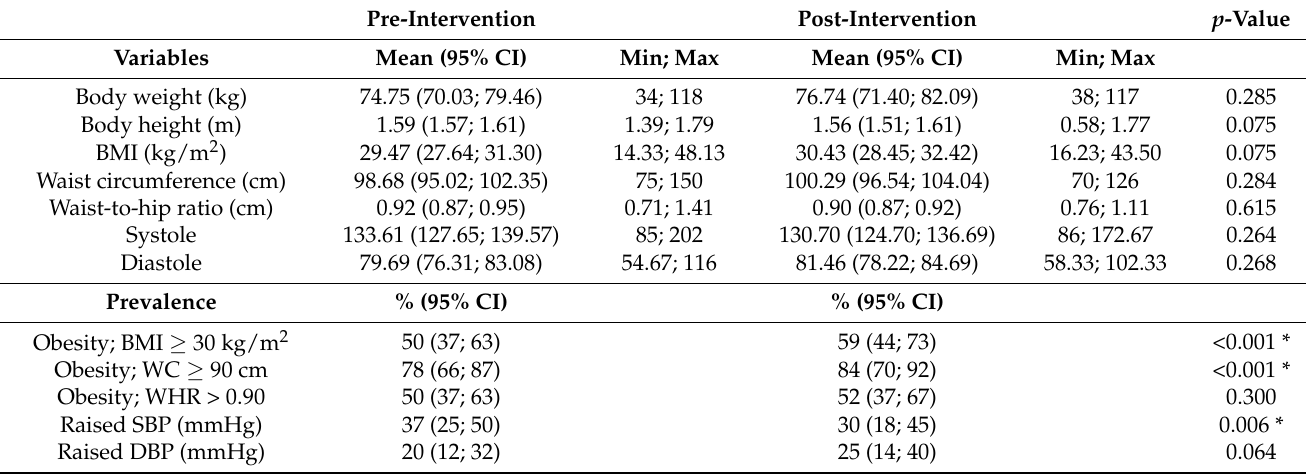
Table 2. Pre-intervention against post-intervention results for patients at a moderate risk of CVD.